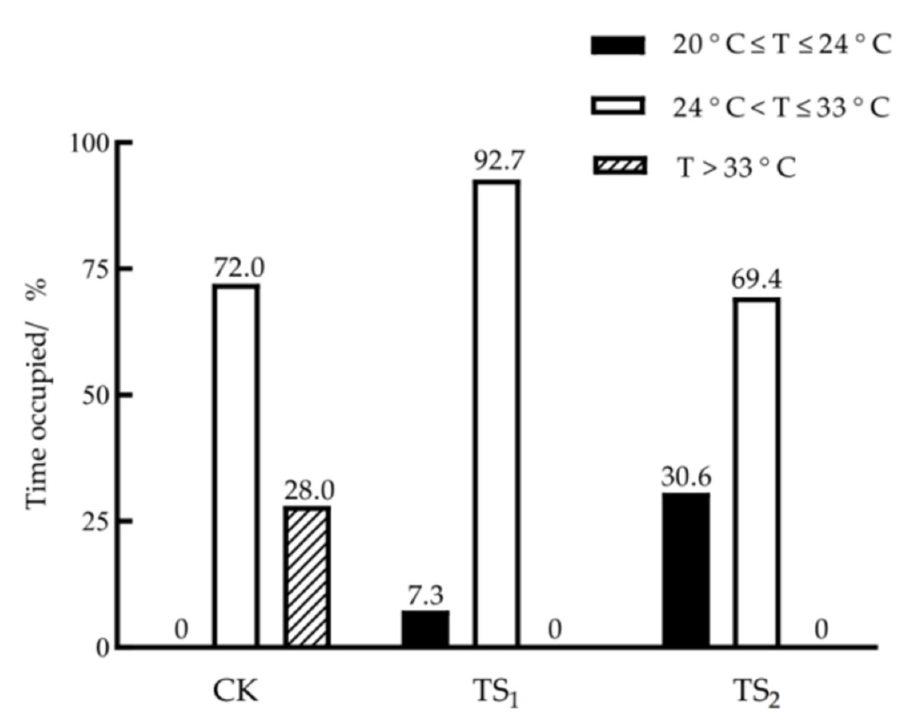
Figure 5. Percentage of substrate temperature in each temperature interval for seven consecutive